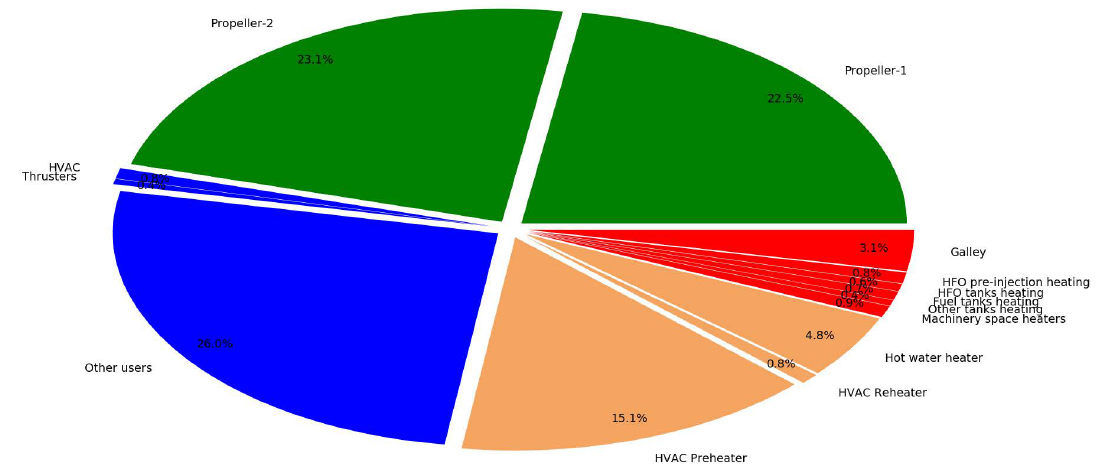
Figure 13. Total ship energy demand subdivided by user, aggregated data for one year of operations. Green and blue areas refer to mechanical and electric power, respectively. Orange and red refer to low- and high-temperature heat demand, respectively.